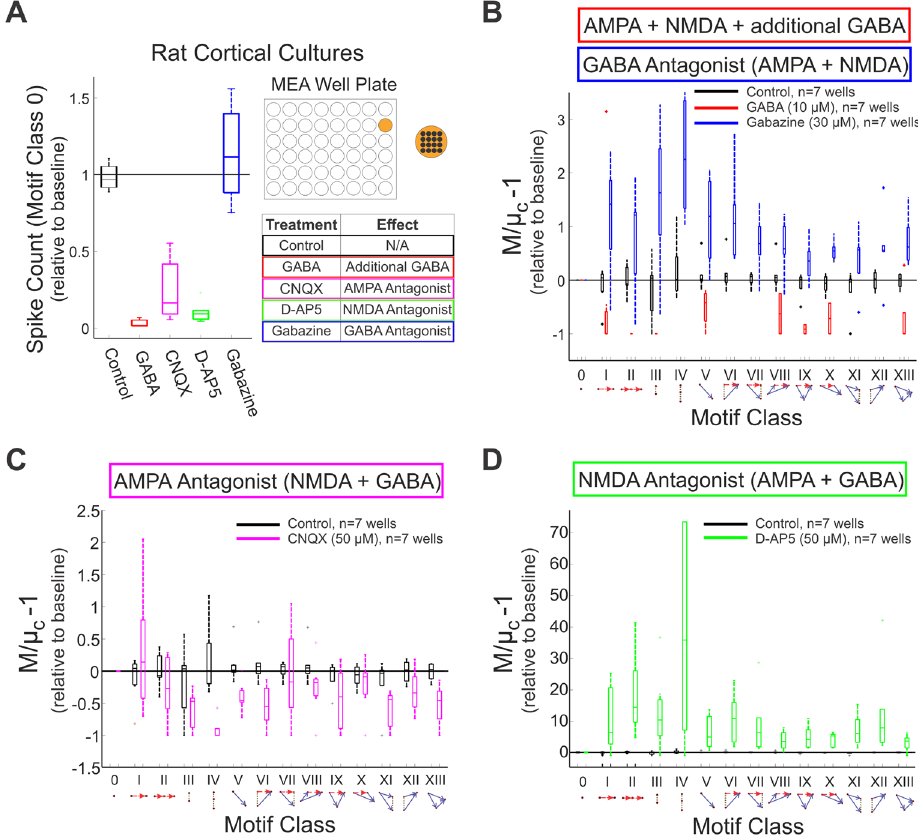
Figure 6. Application of the triple correlation approach to experimental data. We determined motif-class contributions in an open-source dataset of rat cortical cultures 21 . Networks ( n = 70 wells; n = 35 baseline and n = 35 treated) were cultured on microelectrode array (MEA) well plates—each well configured with 4 x 4 electrodes. The treated wells were exposed to the following experimental conditions ( n = 7 wells per condition): control (black), GABA (red), gabazine (blue), CNQX (magenta), and D-AP5 (green). Each treatment well was matched to an untreated baseline well. For each motif class, we depict the distribution of ratios between the treatment and baseline wells. In these box-and-whisker plots, the centerline is the median, the bottom and top edges of the box are the first and third quartiles, and the whiskers extend to the minimum and maximum values. ( A ) The normalized spike counts relative to baseline (contributions of motif class 0) are shown for each experimental condition. The table shows the effect of each of the experimental conditions. ( B ) M /µ c − 1 values are shown for control-, GABA-, and gabazine-treated cultures. Note that some motif classes (IV, VI, VII, XI, XII) do not show values for GABA treatment due to lack of spiking. ( C ) Results for control- and CNQX- treated cultures. ( D ) The motif-class spectra for control and D-AP5-treated cultures indicate increased network structure for the latter, while its level of activity was reduced (Panel A